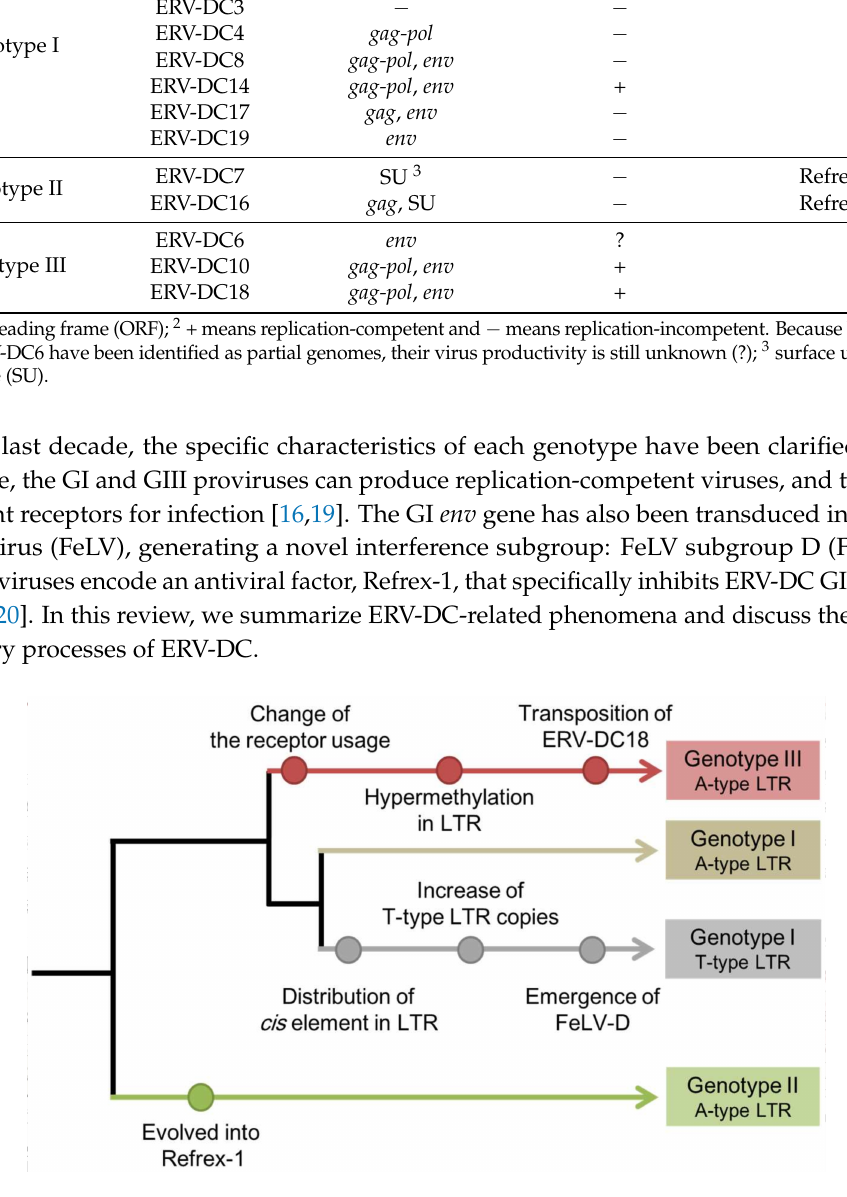
Figure 1. Genotype-specific phenomena in the evolution of ERV-DC. ERV-DC proviruses are phylogenetically classified into three genotypes: genotype I, genotype II, and genotype III. ERV-DC proviruses are also classified into subgroups according to a cis -acting element in the LTR: the